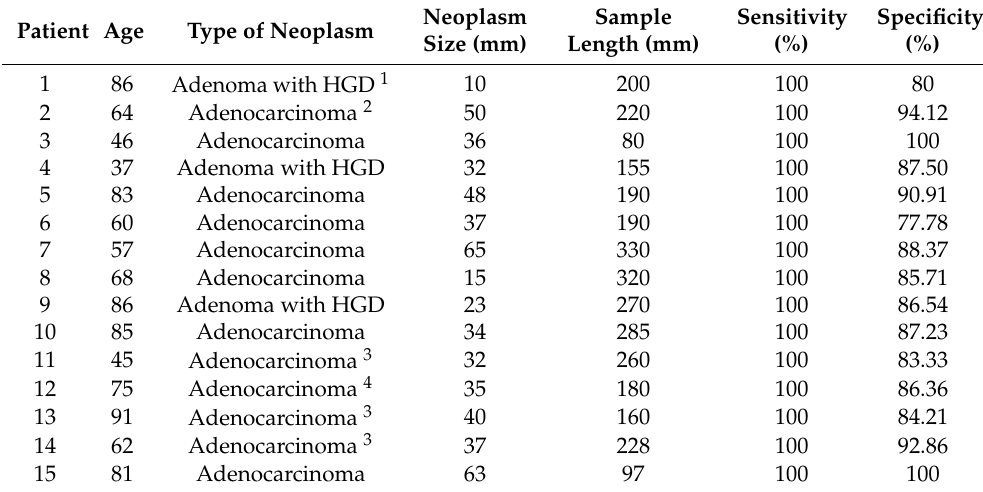
Figure 4. Setup for ex vivo human colon measurements: ( a ) setup for the exploration of ex vivo human colon samples with MiWEndo’s accessory; ( b ) setup for measuring the dielectric properties of ex vivo colon samples with the open-ended coaxial probe method. Table 1. Characteristics of the trajectories measured in human colon models and performance evaluation of the implemented algorithm in terms of sensitivity and